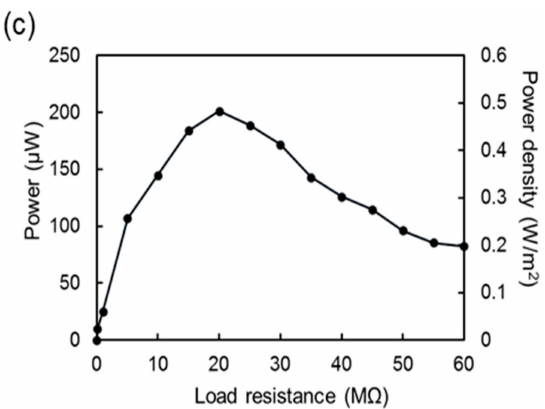
Figure 7. ( a ) Peak-to-peak open-circuit voltage and short-circuit current from 5 × 5 arrays at various frequencies. ( b ) Out voltage and current from 5 × 5 arrays for various load resistances. ( c ) Output power and power density for various load